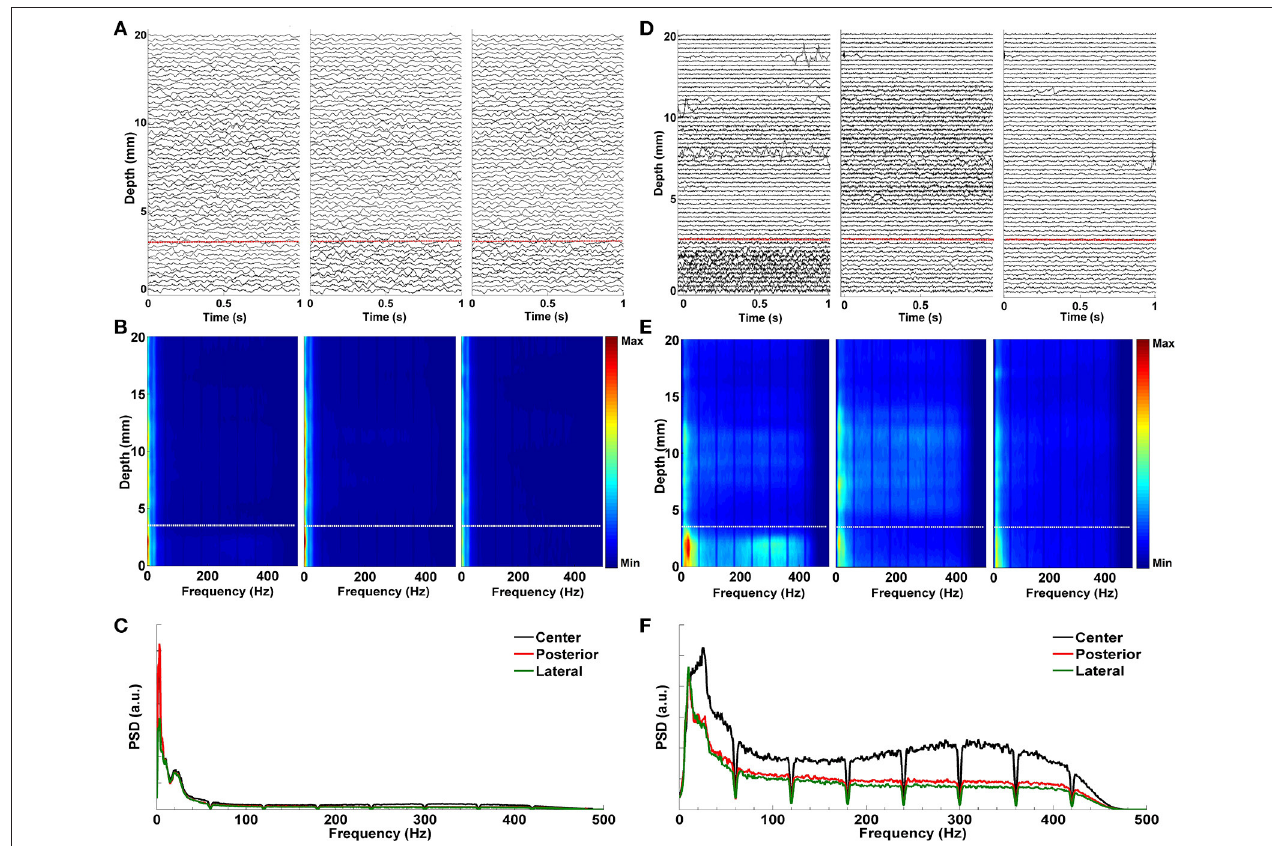
FIGURE 6 | Effect of LMS algorithm by comparing it to the raw LFP signals. (A) Raw LFP distribution. Raw LFPs were recorded from 20mm above the estimated target down to 0mm. Distribution of raw LFPs in each depth shows no visible difference between tracks. Red dashed line indicates the dorsal border of STN. (B) Depth frequency map (DFM) generated from raw LFPs. Neither pathological beta oscillations nor HFOs are visible in tracks. The high-energy and low band common activity masks other oscillations. White dashed line indicates the dorsal border of STN. (C) Power spectrum of raw LFPs. It was generated from the LFP data below the dorsal border of STN. The high correlation between tracks in low frequencies can be clearly seen. Since HFOs are masked by these low frequency oscillations, it is not possible to distinguish them in the spectrum. (D) De-correlated LFP distribution. Effect of LMS algorithm on the raw LFPs is clearly seen. Target specific oscillations are visible on de-correlated LFP data. The red dashed line shows the dorsal border of STN determined by MER-SUA. (E) DFM of de-correlated LFPs in each microelectrode track. The high energy oscillations in distinct low and high frequency bands inside the STN (below the white dashed line) can be clearly seen in the first track. (F) Power spectrum of de-correlated LFPs. Tracks do not show excessive and correlated beta activity anymore. There is an increase in the gamma band (35–55Hz) and great enhancement in HFO range (200–400Hz) in the first track compared to other